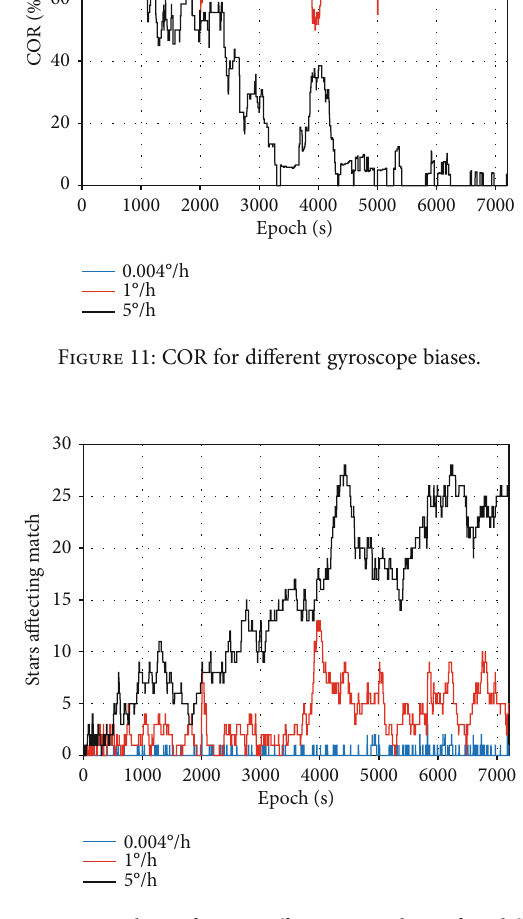
Figure 12: Number of stars a ff ecting matching for di ff erent gyroscope